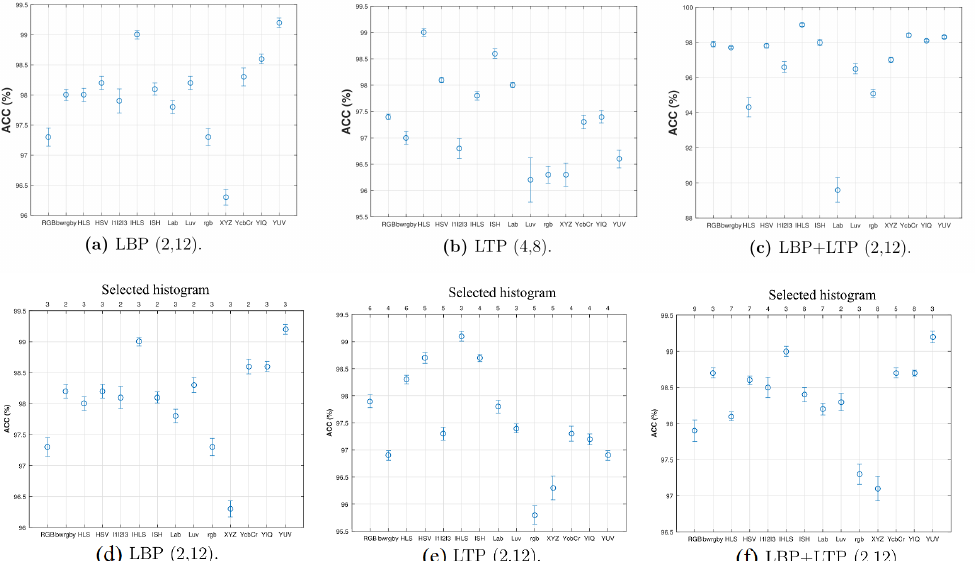
Figure 6. Highest results obtained on the SWIMCAT dataset without (first row) and with (second row) histogram selection method.